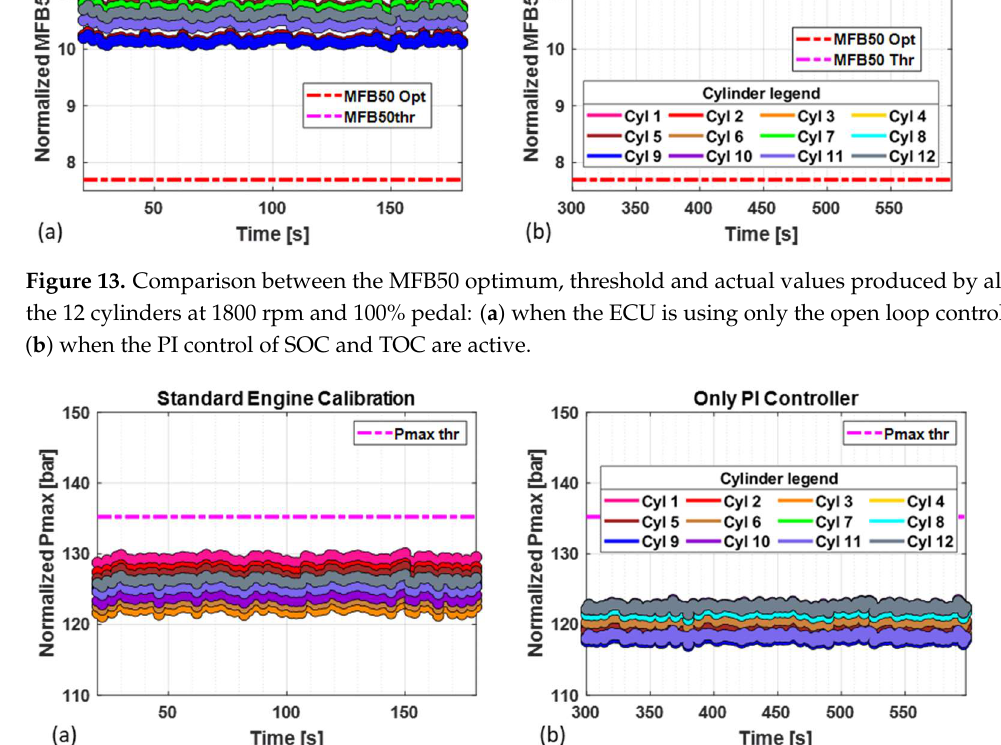
Figure 14. Comparison between the Pmax threshold, the Pmax limit and the actual values of Pmax produced by all 12 cylinders at 1800 rpm and 100% pedal: ( a ) when the ECU is using only the open loop control, ( b ) when the PI control of the SOC and TOC are active.